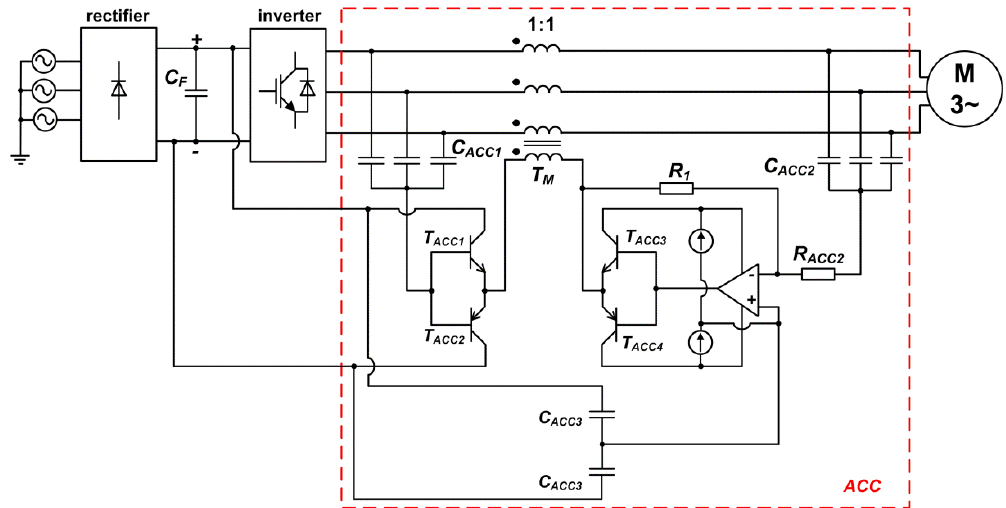
Figure 6. Active common noise canceller.